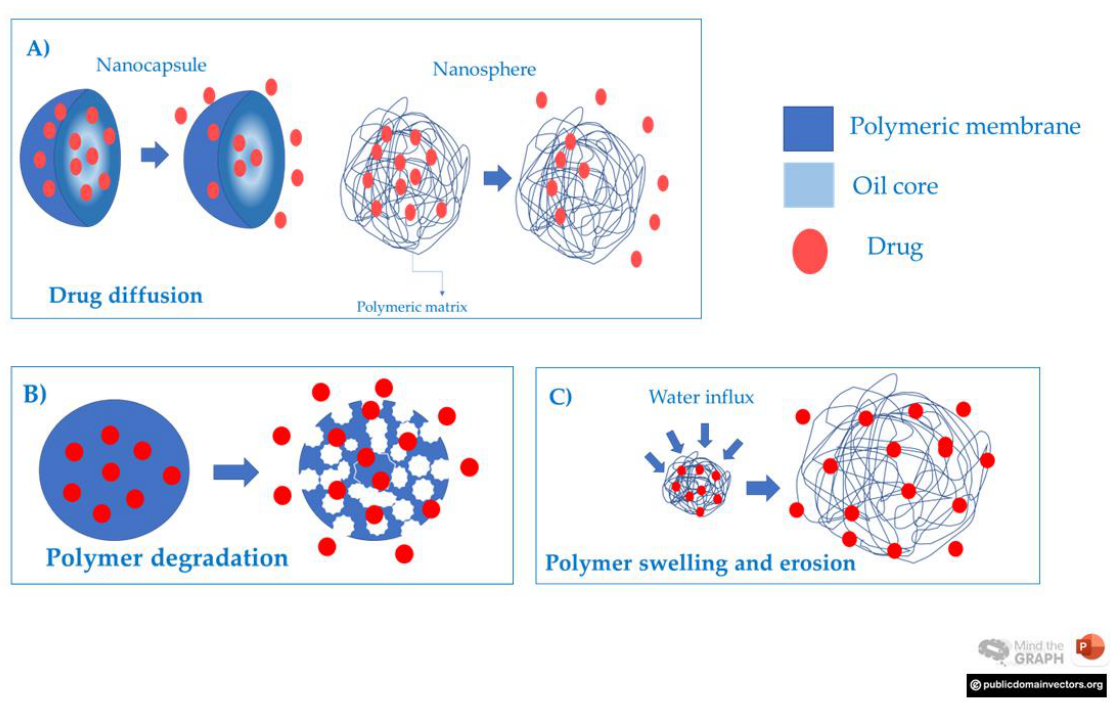
Figure 7. Mechanisms of controlled and sustained drug release from polymeric nanoparticles: ( A ) drug diffusion through the matrix, ( B ) polymer degradation, and ( C ) polymer swelling and erosion. The image was created using Mind the Graph platform (www.mindthegraph.com, accessed on 8 January 2022), Publicdomainvectors.org site (https://publicdomainvectors.org/, accessed on 8 January 2022), and Microsoft ® PowerPoint ® (USA).